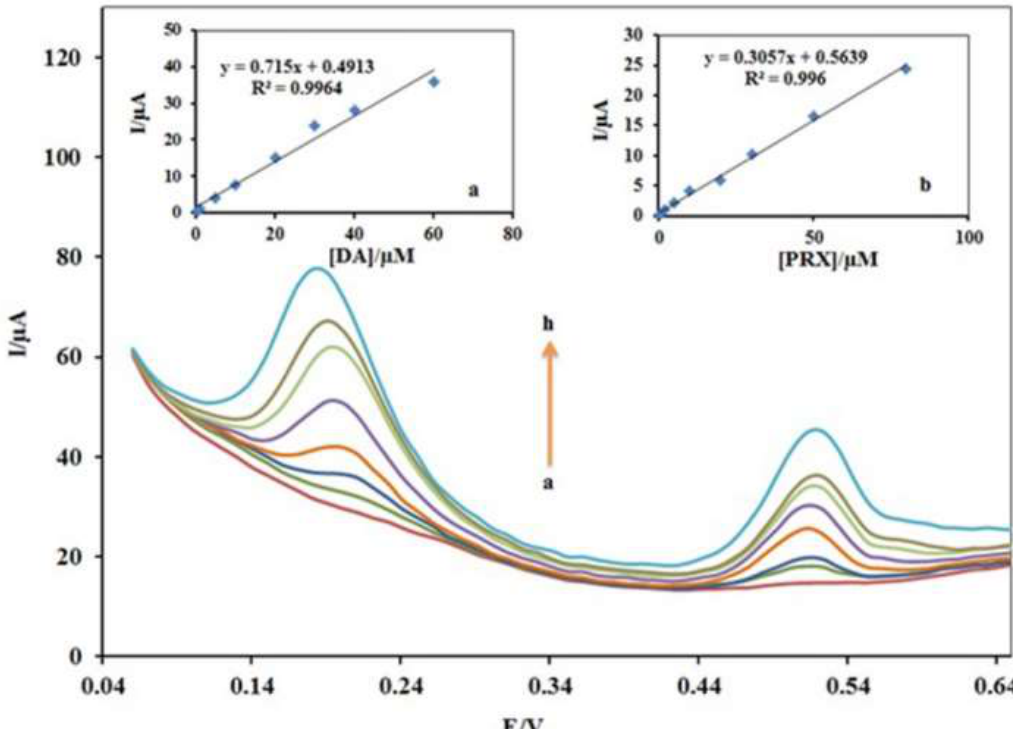
Fig. 7. Differential pulse voltammograms for different concentrations of DA and PRX mixture in presence of 0.4mM AA as (a) 0.3 + 0.4, (b) 1 + 2, (c) 5 + 5, (d) 10 + 10, (e) 20 + 20, (f) 30 + 30, (g) 40 + 50 and (h) 60 + 80 respectively, in which the first value is the concentration of DA in μM and the second value is the concentration of PRX in μM. Insets: (a) Plot of peak currents as a function of DA concentration. (b) Plot of the peak currents as a function of PRX